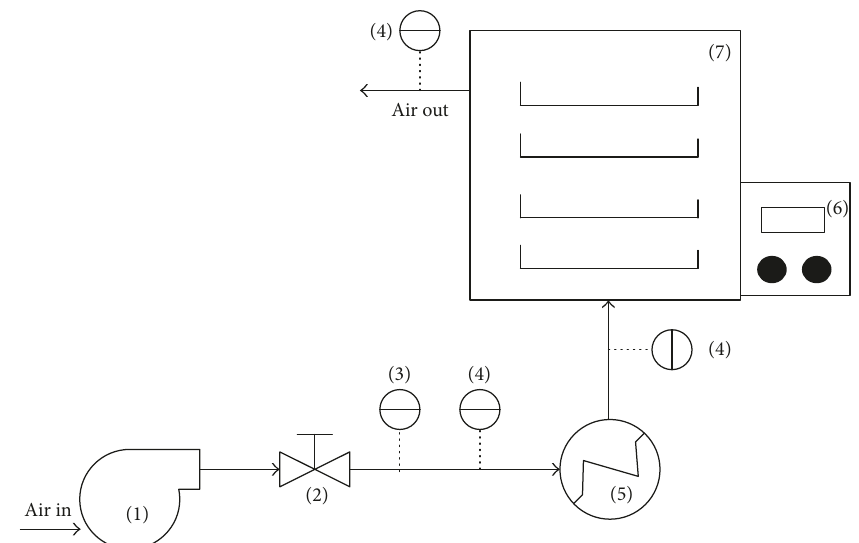
Figure 1: The schematic overview of the tray drying equipment ((1) blower; (2) valve; (3) temperature and relative humidity sensor (T-RH); (4) temperature and velocity sensor (T-V); (5) heater; (6) thermocontroller; (7) drying chamber).